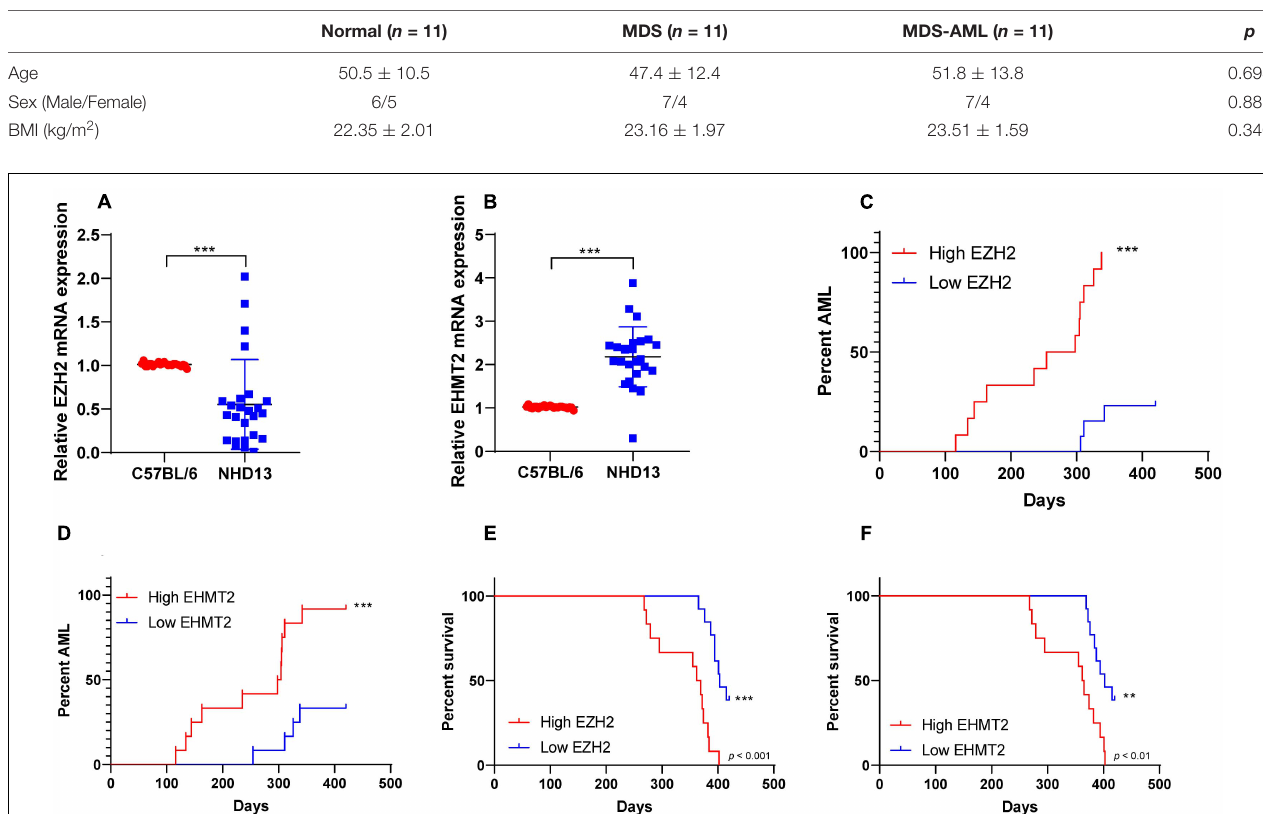
TABLE 2 | General information of the cases.